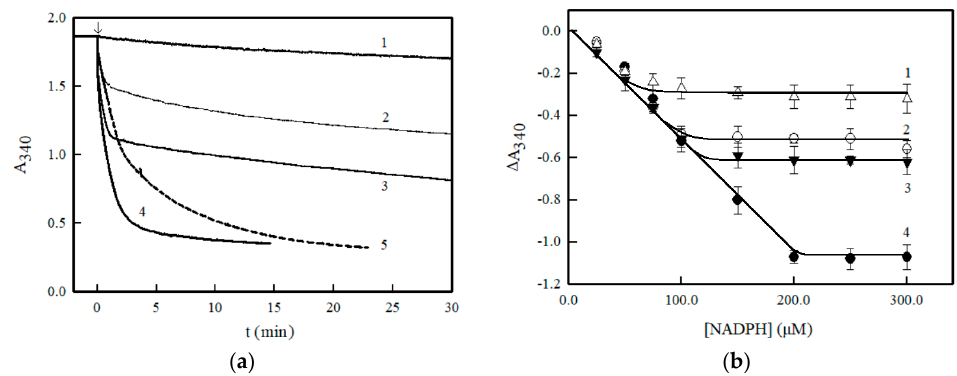
Figure 3. ( a ) Kinetics of oxidation of 300 µM NADPH by 50 nM NfsA in the absence of electron acceptor (1), or in the presence of 50 µM TNT (2,3), or 50 µM tetryl (4,5). The reaction mixture additionally contained 2.0 mM ascorbate in two of the reactions (2,5); ( b ) The changes in absorbance at 340 nm during the first phase of oxidation. Oxidant: 50 µM TNT (1,2), 50 µM tetryl (3,4), 2.0 mM ascorbate was present (1,3), or absent